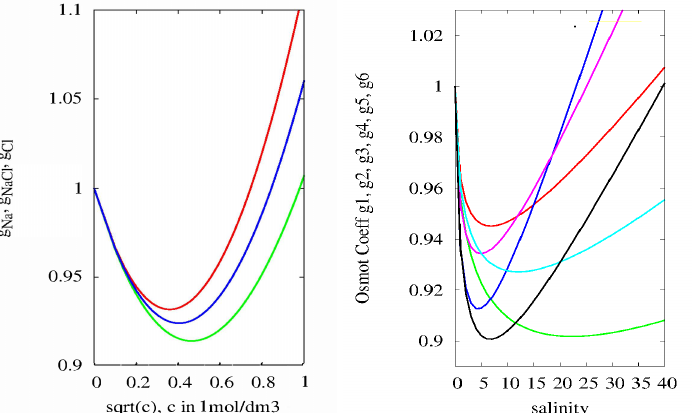
Figure 2. Left panel: Relative pressure for the ions Na + (above) and Cl − (below) as well as the mean for a NaCl-solution. Right panel: Relative (individual) osmotic pressures for a mixture of six ions mimicking seawater including association in dependence on salinity S (gram salt per liter). We are sorting from below looking at the values at salinity S = 5. The lowest curve represents the ion SO 2 − then follow the curves for Mg 2 + , K + , Ca 2 + , Cl − , Na +